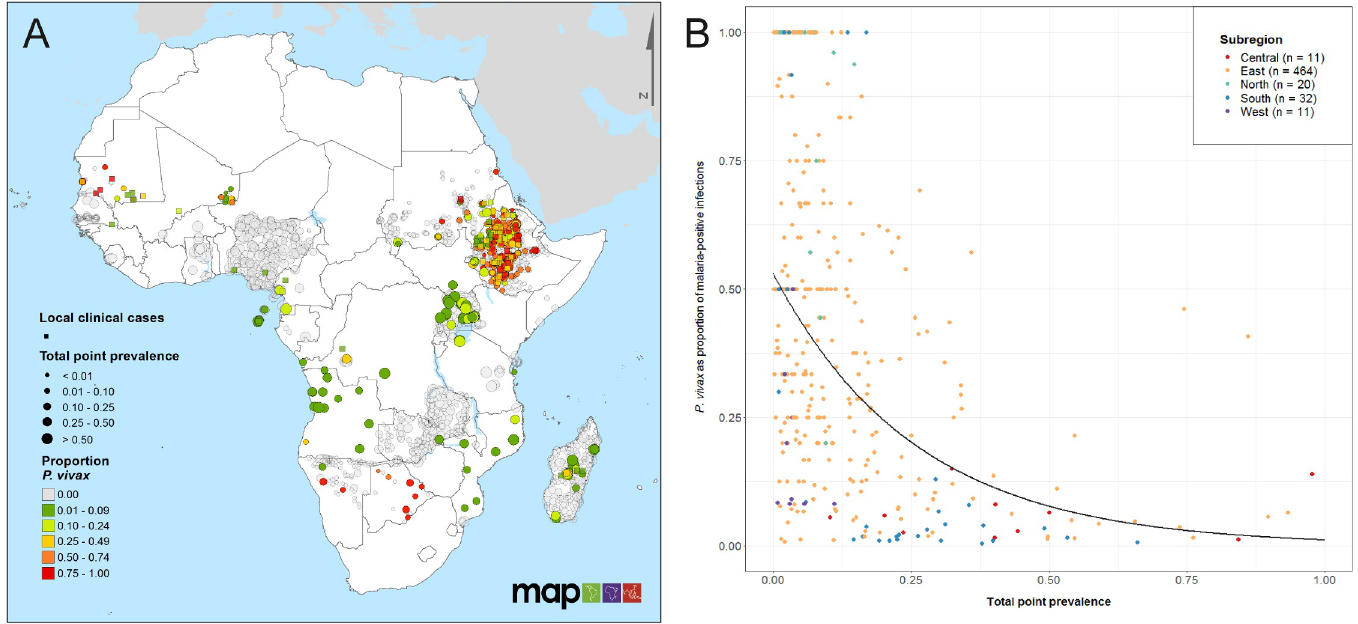
Fig 2. Relationship between proportion of infections due to P . vivax and total malaria prevalence across Africa. Panel A shows the spatial distribution of the proportion of P . vivax infections relative to P . falciparum , based on a subset of sources from the final database that tested for both P . vivax and P . falciparum , and employed representative sampling methods. Prevalence points (round dots, total n = 3,329; n = 565 with P . vivax proportion > 0) are coloured according to the proportion of infections due to P . vivax , and sized according to the total point prevalence at each site. Clinical case reports where the species proportion could be determined are represented as squares (n = 152) and also coloured by P . vivax proportion. S6 Fig shows the equivalent map with points sized by sample size. Panel B plots site-wise proportion of infections due to P . vivax (y-axis) in relation to overall community prevalence (x-axis) at locations where the total number examined was at least 30 individuals and at least one P . vivax infection was detected (n = 538). Only surveys that used diagnostic methods sensitive to both P . vivax and P . falciparum were included. Points are coloured according to African Union regions (S1 Fig) [47], with trend lines added as a visual guide.